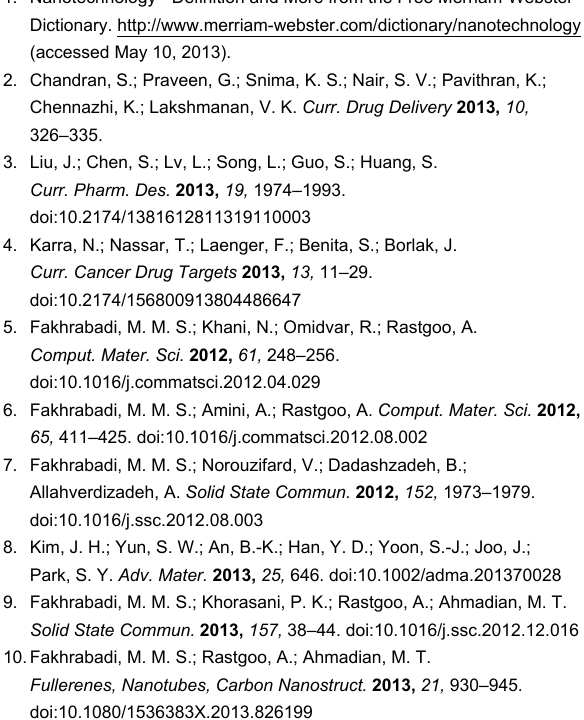
application of MCST, the pull-in voltages for CNTs that convey low viscosity fluids dominate the voltages that are related to high